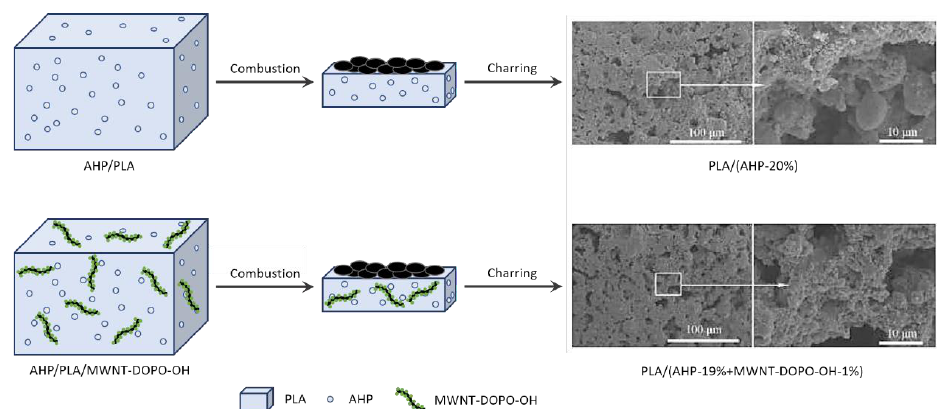
Figure 22. Schematic of the synthesis of MWNT – DOPO-OH. Reproduced with permission from Ref. [176]. Copyright 2018, Elsevier.